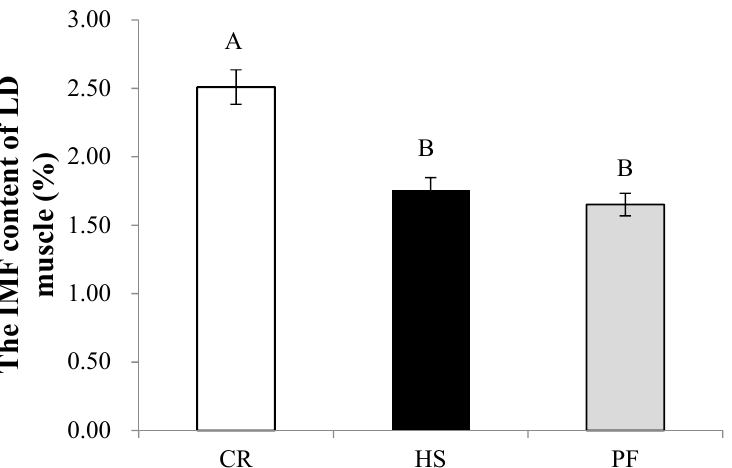
Figure 6. Effects of constant heat stress on the IMF content of LD muscle in finishing pigs. IMF: intramuscular fat in LD muscle, n = 8. Values with different capital letter superscripts indicate significant differences ( p < 0.01).